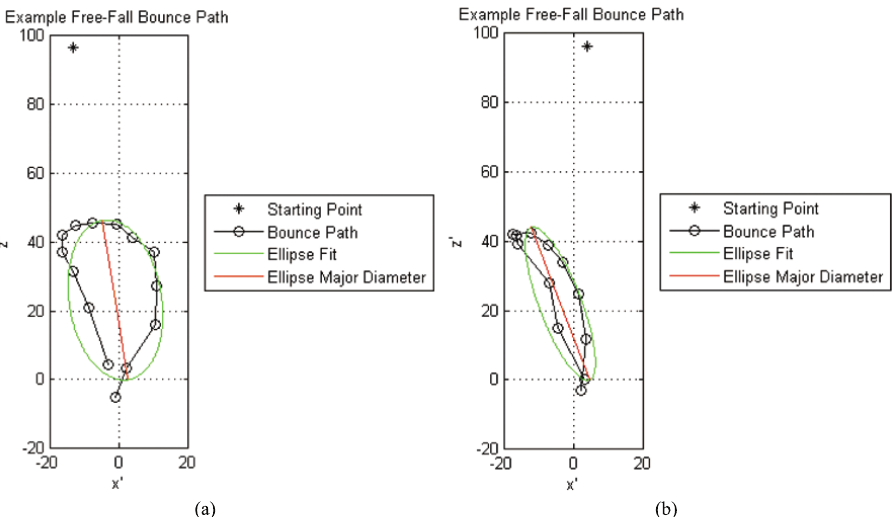
Fig. 21. The ellipse parametrization also performed well for characterizing free fall